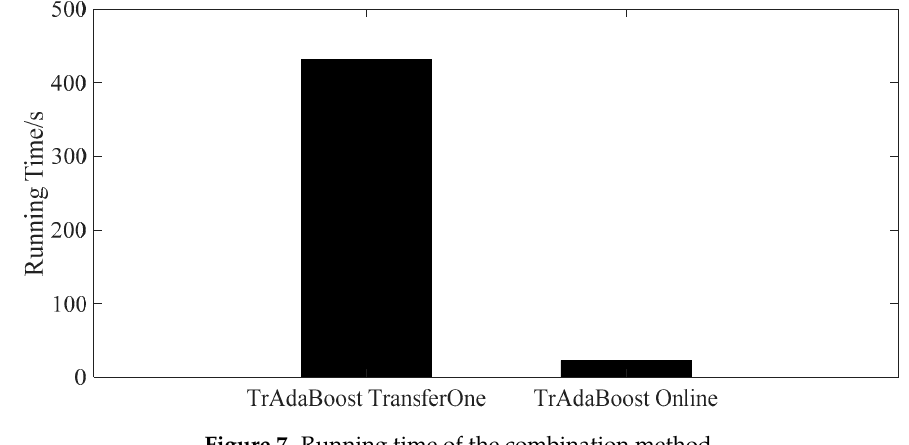
Figure 7. Running time of the combination method.